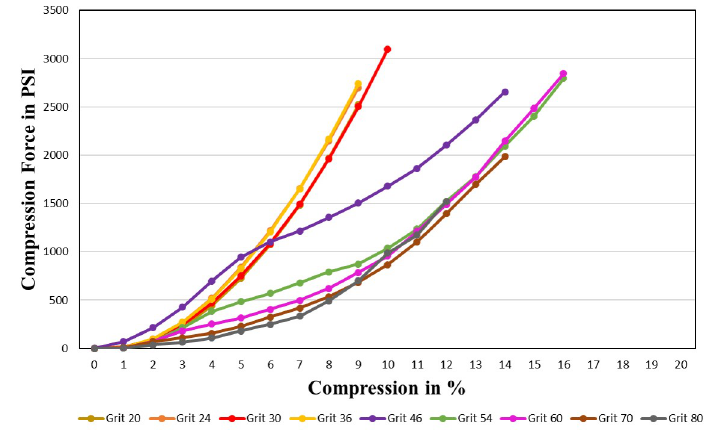
Figure 17. Compression force for different percentages of compression.